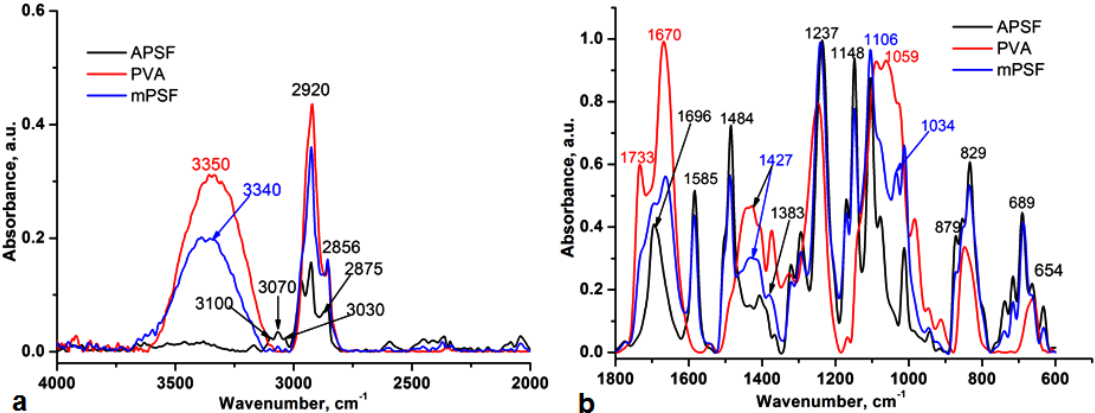
Figure 2. The ATR-IR spectra of PVA, APSF, and mPSF matrices in the 4000–2000 cm − 1 ( a ) and 1800–500 cm − 1 ( b ) spectral ranges.